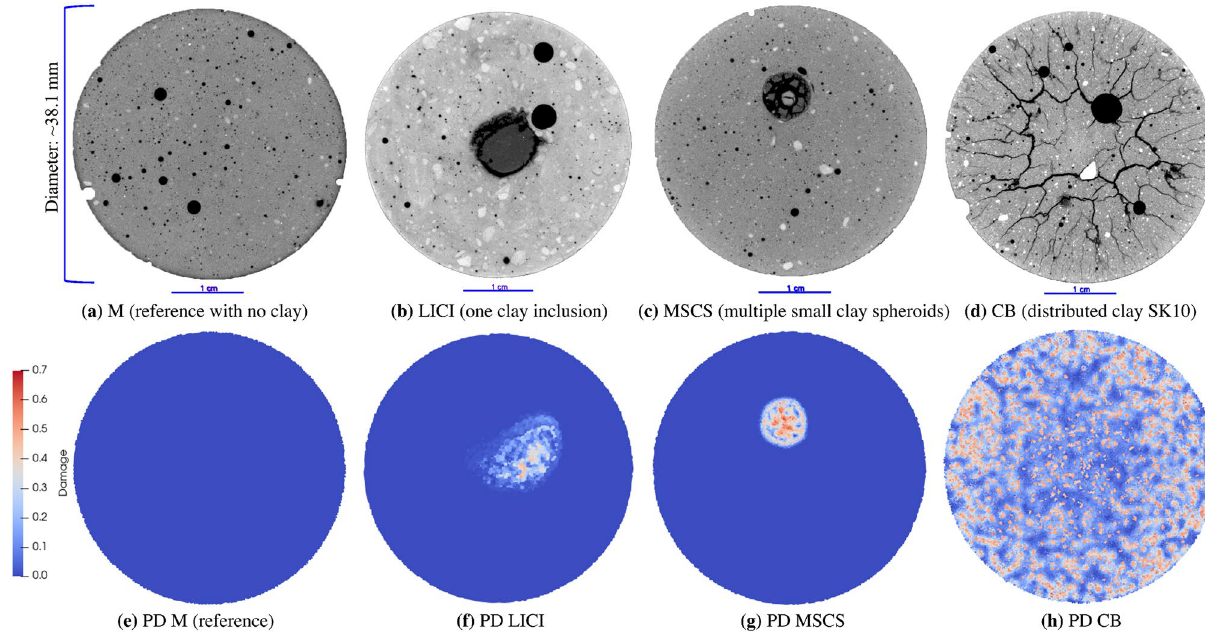
Figure 2. A comparison of the experimental and simulated damage, where the top row is comprised of two-dimensional (2D) images at the center of each geo-architected sample: ( a ) the reference sample with no visible cracks, ( b ) LICI and ( c ) MSCS with fractured regions in and surrounding the inclusions, and ( d ) the CB sample with many visible cracks. The bottom row is comprised of 2D images of the PD model results for each experimental structure: ( e ) is the data obtained for the reference model, ( f ) is data for the LICI sample, ( g ) is data for the MSCS sample, and ( h ) is data for the CB-SK10 sample. Damage is observed in both the experimental and PD models, and is localized and/ or distributed in areas that contain highly-shrinkable clay. All images are viewed along the transverse plane after six (6) full days of dehydration. Experimental data are processed with Dragonfly Pro software, Version 2020.2 for [Windows] from ORS 13